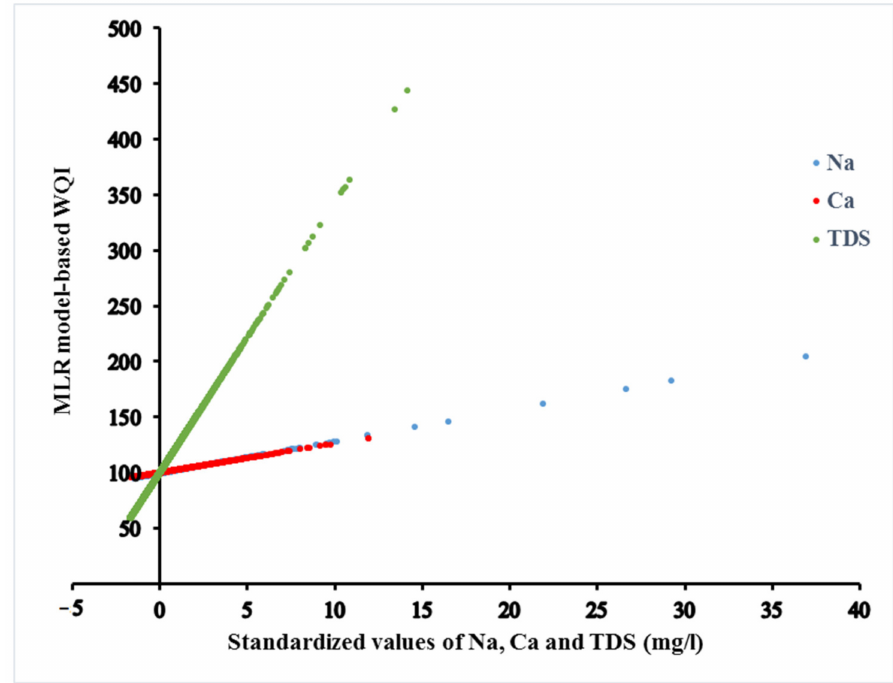
Figure 4. Slope of the line for the variables of the ANN CGD training algorithm-based MLR